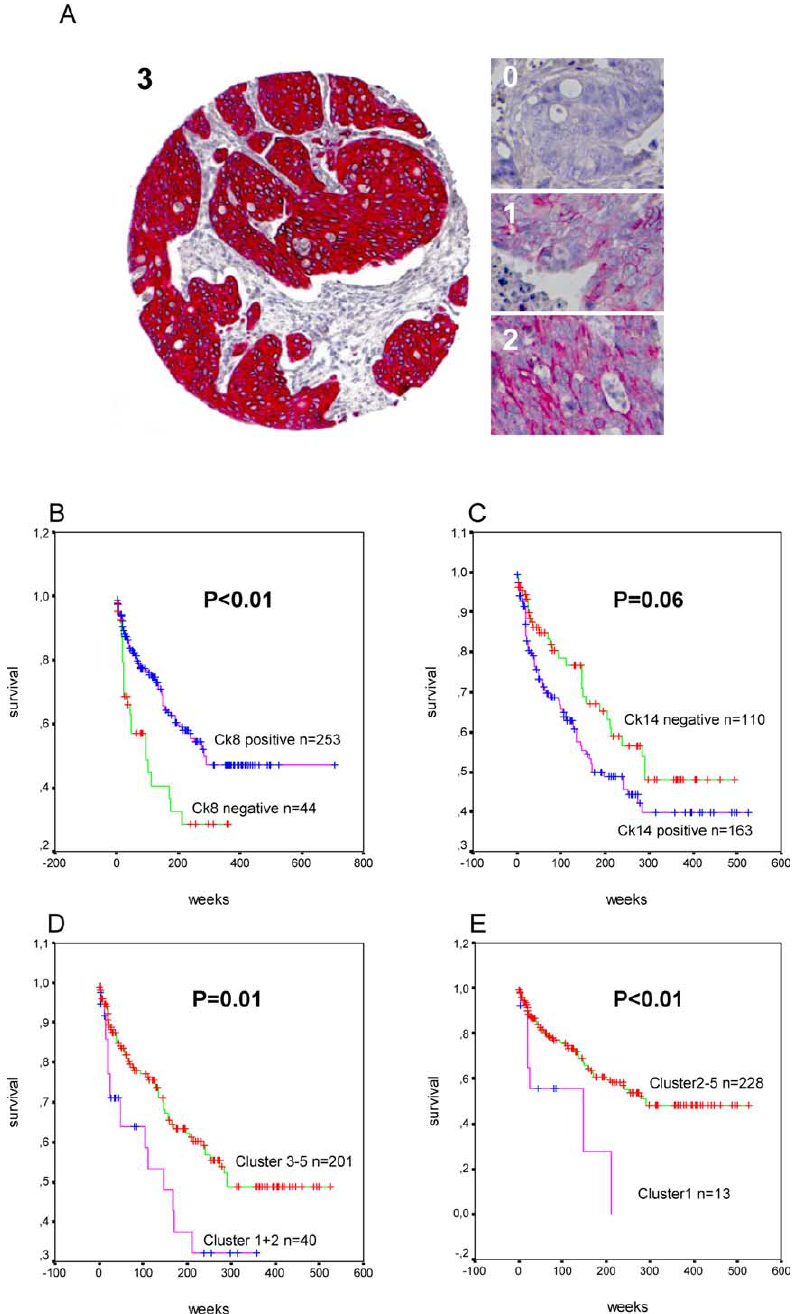
Fig. 1. (A) Examples of the immunohistochemical assessment of Cytokeratin 8 (CK8) staining in colorectal carcinomas using TMAs. Negative staining of tumour cells (0), weakly positive (1), moderately positive (2), strongly positive (3) (50 × magnification). (B) Kaplan–Meier plot com- paring disease-specific survival in patients with CK8-positive colorectal tumours ( n = 253) and patients with CK8-negative tumours ( n = 44), p < 0 . 01. (C) Kaplan–Meier plot comparing disease-specific survival in patients with CK14-positive colorectal tumours ( n = 163) and patients with CK14-negative tumours ( n = 110), p = 0 . 06. (D) Kaplan–Meier plot comparing disease-specific survival in Cluster 1 and 2 “shorter survival clusters” with Clusters 3–5, p = 0 . 01. (E) Kaplan–Meier plot comparing disease-specific survival in Cluster 1 “extreme shorter survival cluster” with 2–5, p < 0 .